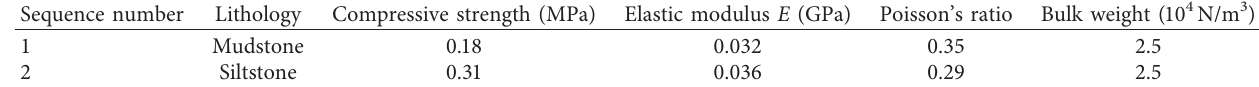
Table 2: Mechanical parameters of rock material transparent table model.